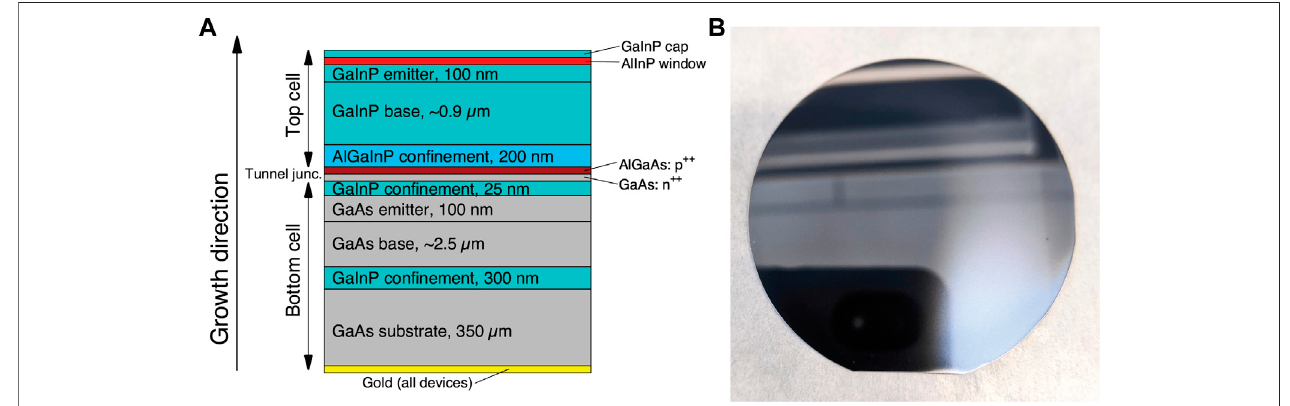
FIGURE 1 | Tandem photoabsorber architecture. (A) The vertical structure of layers in the III – V tandem photocathode characterized in this document. (B) A 2 ″ wafer of (A) , GaInP top surface.